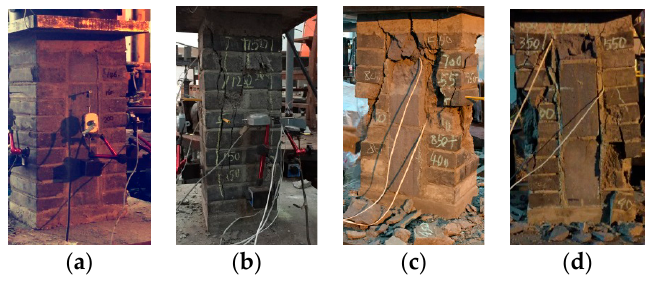
Figure 8. Failure states of ARCB1–ARCB4: ( a ) ARCB1; ( b ) ARCB2; ( c ) ARCB3; and ( d )